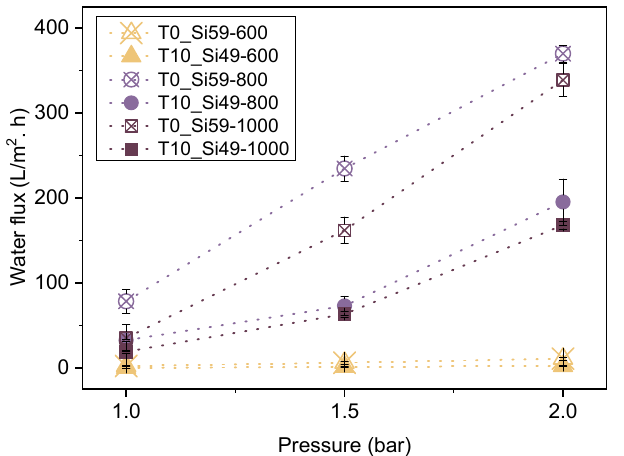
Figure 9. Water flux as a function of the applied pressure (bar) for selected membranes in a dead- end configuration.